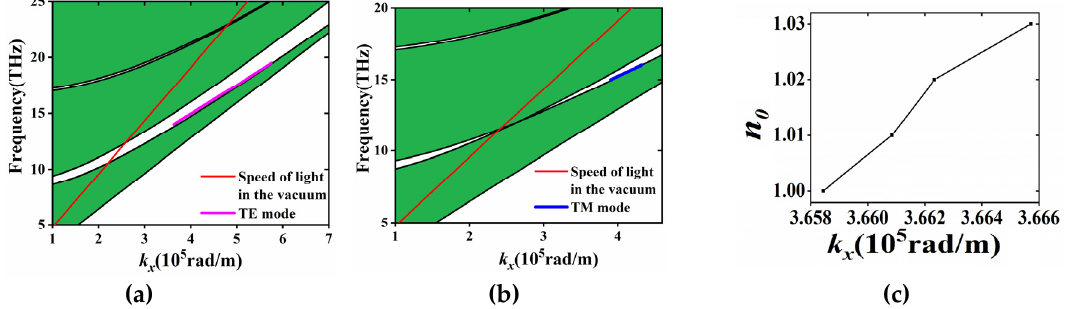
Figure 2. The dispersion relation of the dielectric multilayer for ( a ) TE and ( b ) TM polarization (the white zone denotes the stop band and the blue zone denote the non-radiative modes for the BSW and the red solid lines represents the speed of light in a vacuum, while the green point shows the working mode) when t buf = 24 µ m, t bas = 80 µ m. ( c ) n 0 versus k x when the frequency of the incident terahertz wave is 14 THz, provided with the TE polarization.